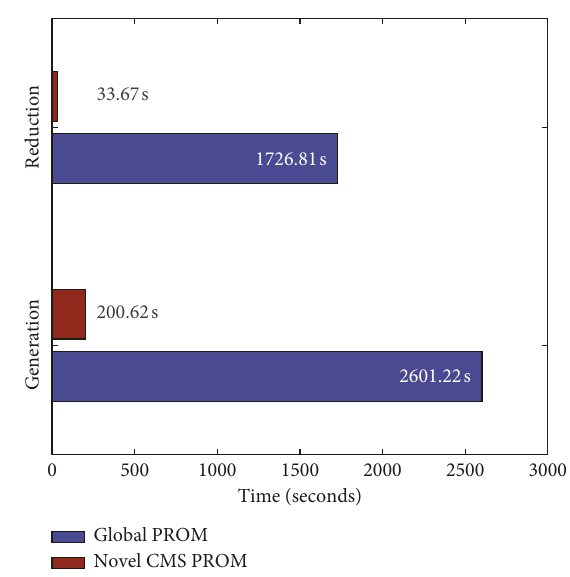
Figure 5: Comparison of offline database construction time be- tween the global PROM and the novel